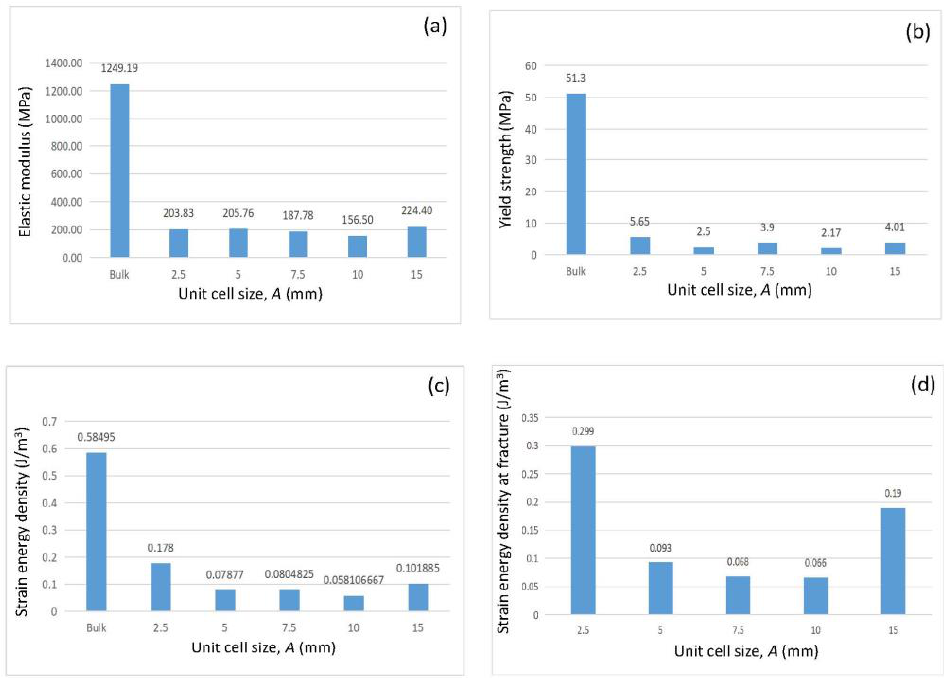
Figure 5. Mechanical properties of various bamboo-like structures: ( a ) elastic modulus, ( b ) yield strength, ( c ) strain energy density at 0.028 strain, and ( d ) strain energy density at fracture. Results for a solid (bulk) structure with the same dimensions and composition are also included for com- parison. Table 1. Mechanical properties of test structures with n = 3 and A / a = 5.